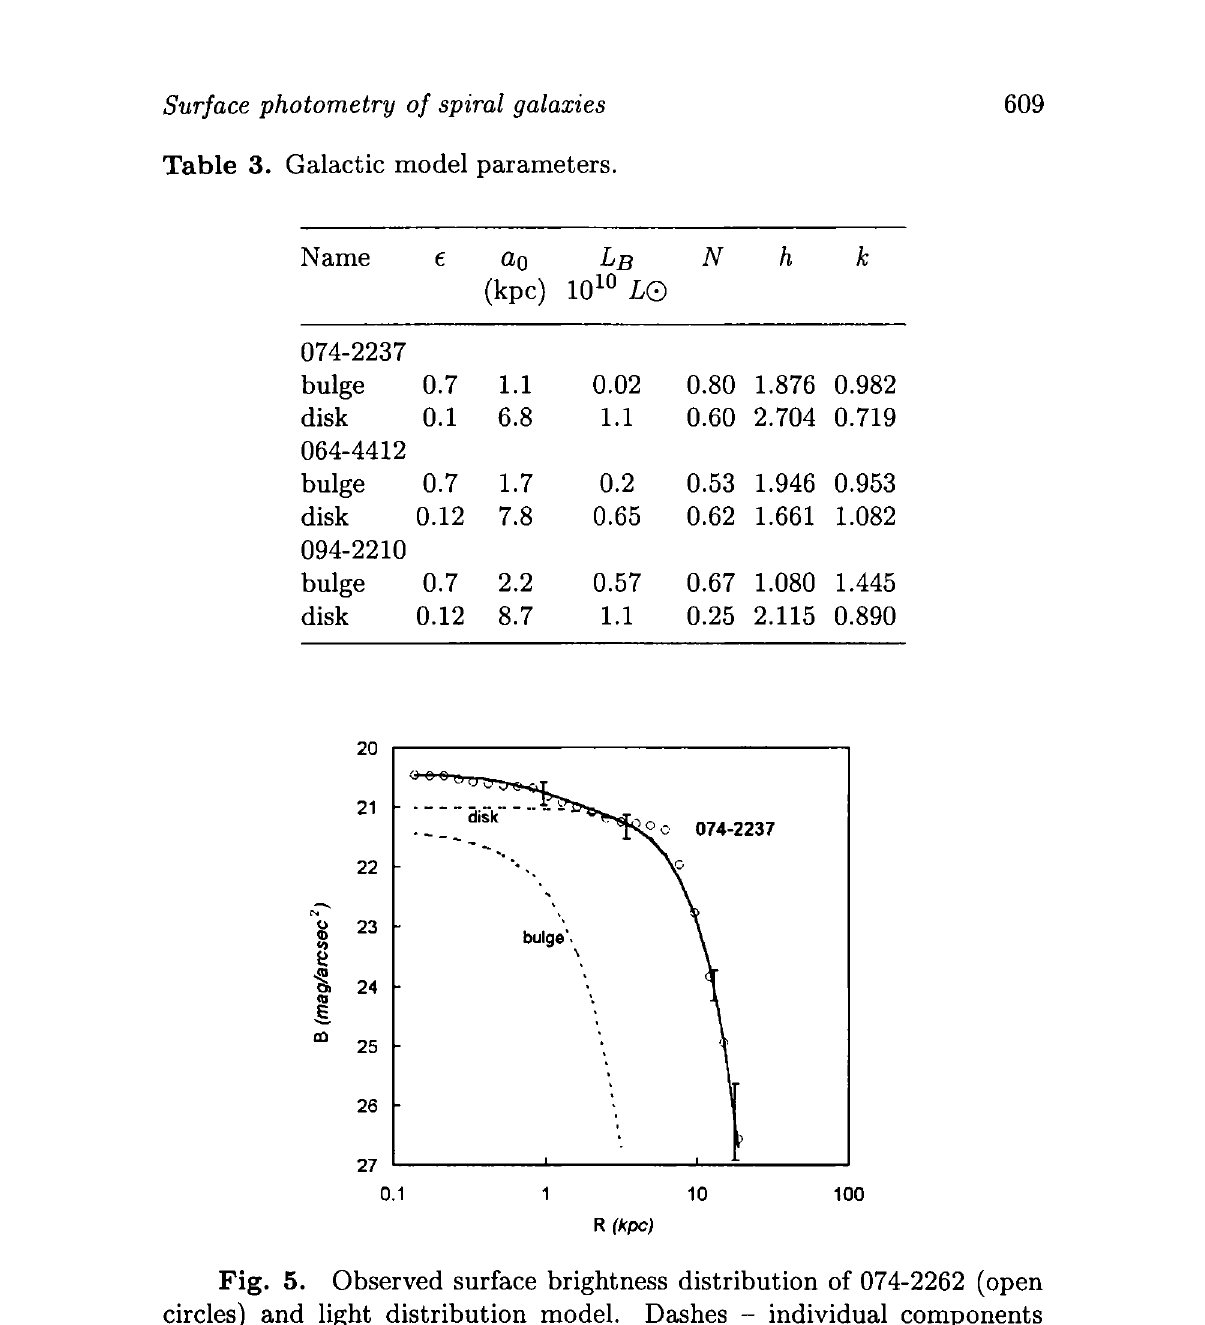
Fig. 5. Observed surface brightness distribution of 074-2262 (open circles) and light distribution model. Dashes - individual components (bulge and disk), solid line - total luminosity